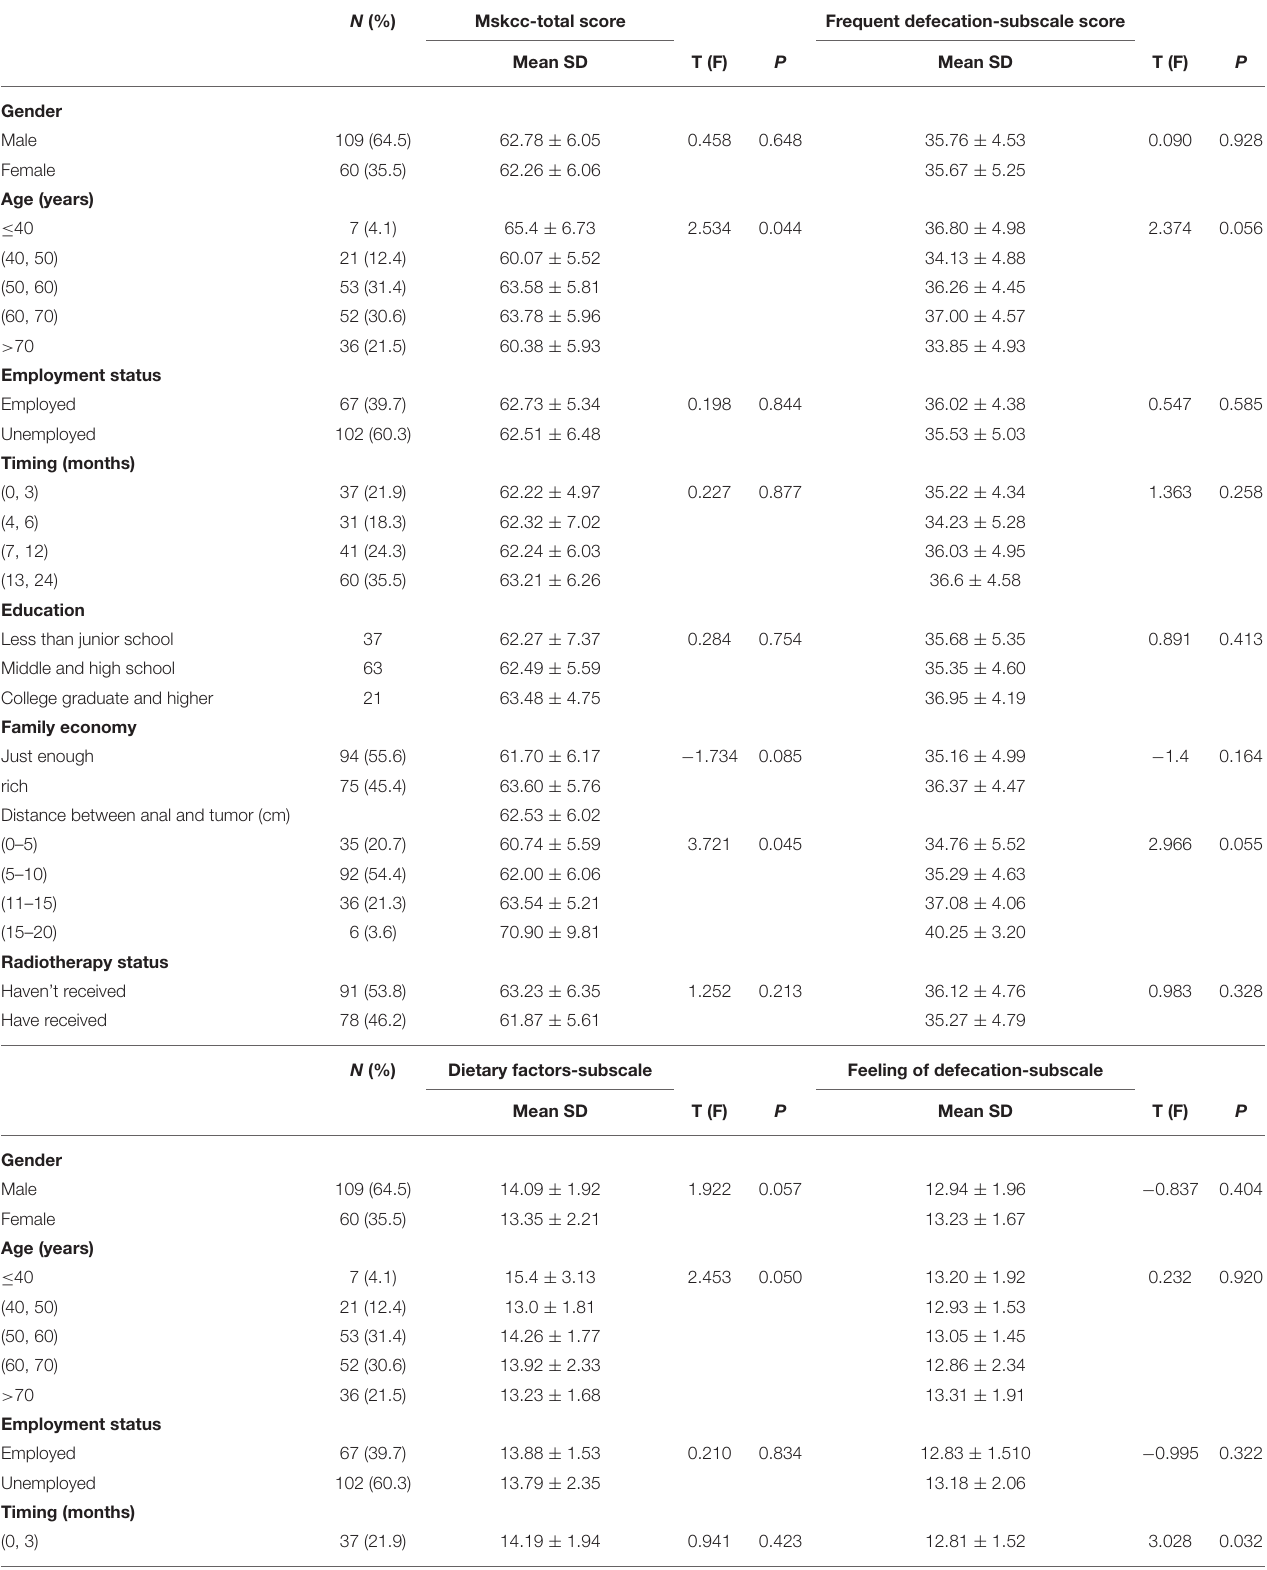
TABLE 1 | Participants’ characteristics and differences of the bowel function in different groups ( N =